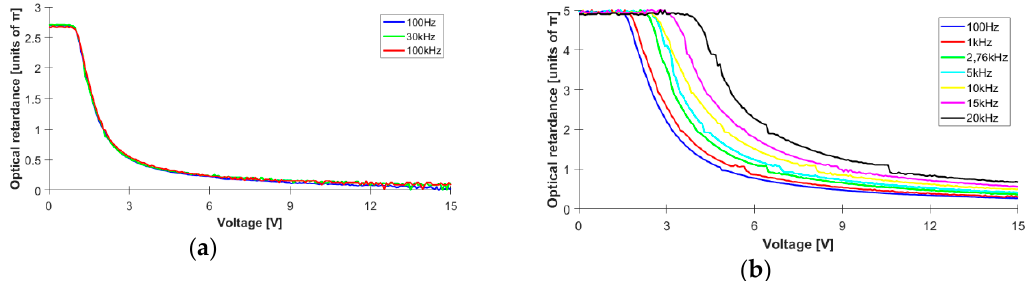
Figure 4. Voltage-dependent phase changes at different frequencies measured in 5 μ m cell filled with: ( a ) formulated mixture, ( b ) 6CHBT liquid crystals.